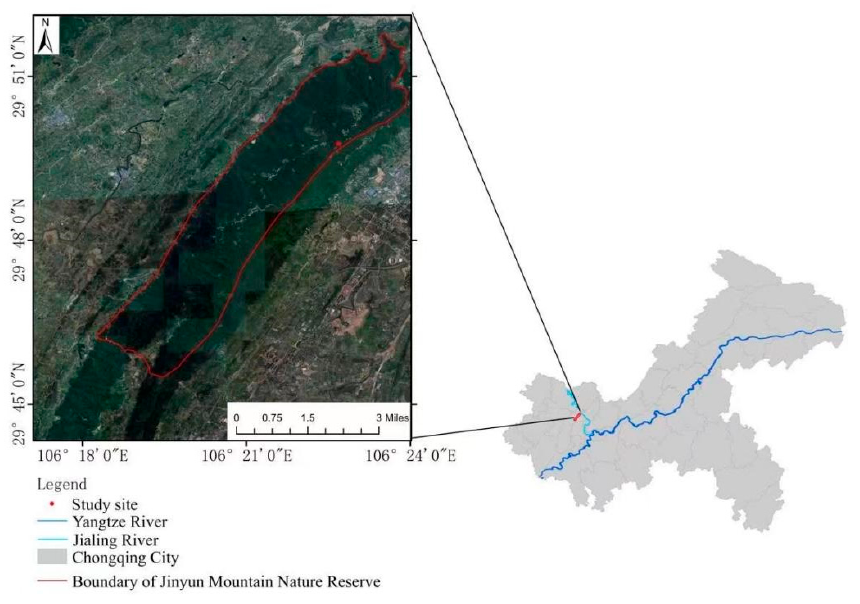
Figure 1. Overview of the study area .